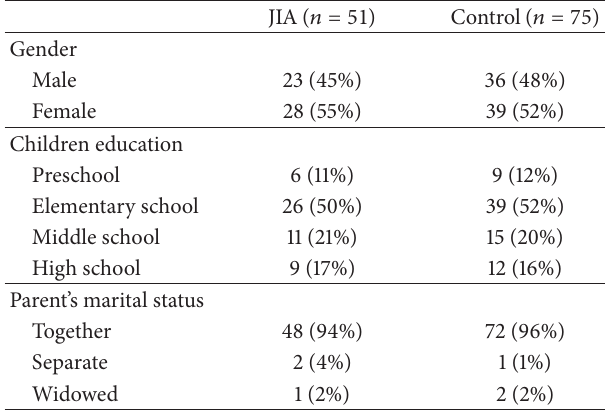
Table 1: Demographic data of juvenile idiopathic arthritis and control